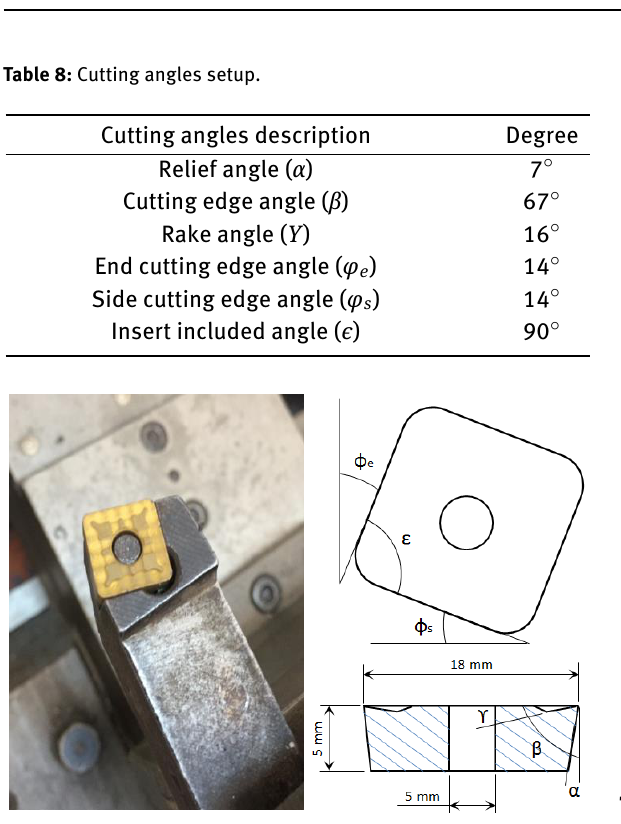
Figure 3: Tool geometry and dimensions.